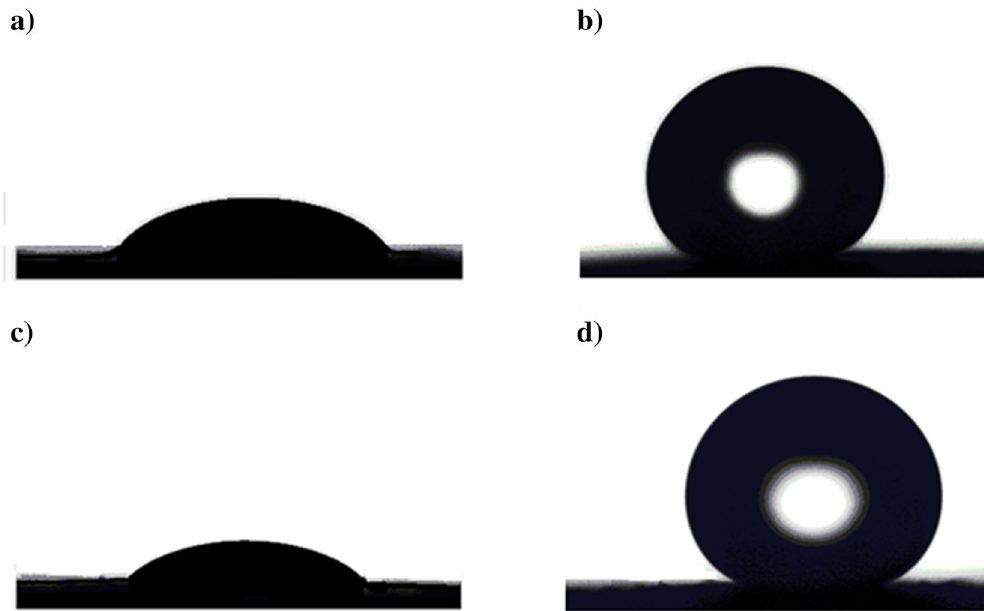
Figure 5. The shape of a water droplet on coated steel by ( a ) Ni@G, ( b ) Ni@G@MA, ( c ) Ni@Cr-G, and ( d ) Ni@